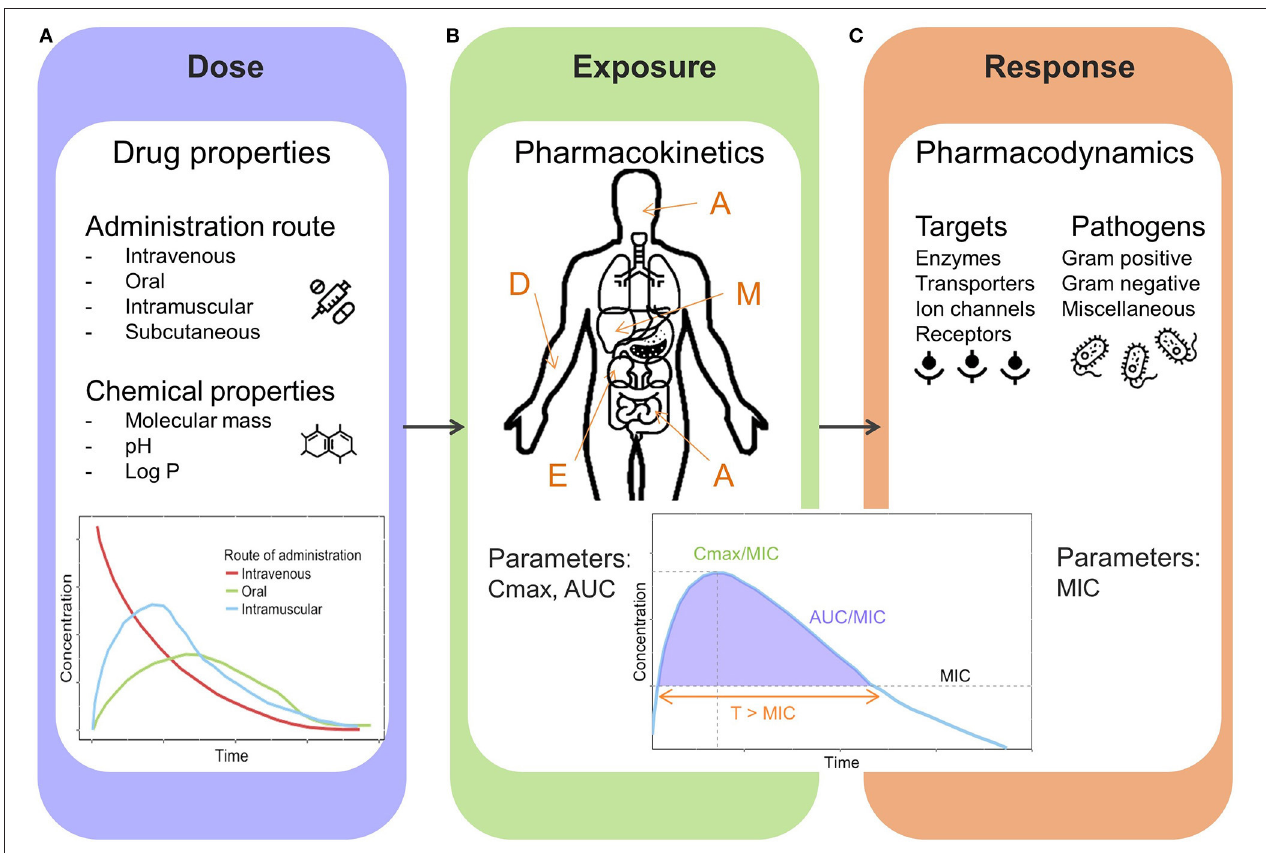
FIGURE 3 | General overview illustrating pharmacological key components. (A) Dose: drug properties and administration routes. (B) Exposure: Pharmacokinetic processes and parameters, A, Absorption (e.g., intestines); D, Distribution (e.g., blood circulation); M, Metabolism (e.g., liver); E, Excretion (e.g., kidneys); Cmax, peak concentration; AUC, area under the concentration-time curve. (C) Response: Pharmacodynamics, targets and pathogens, MIC, minimal inhibitory concentration; T > MIC, time above MIC.